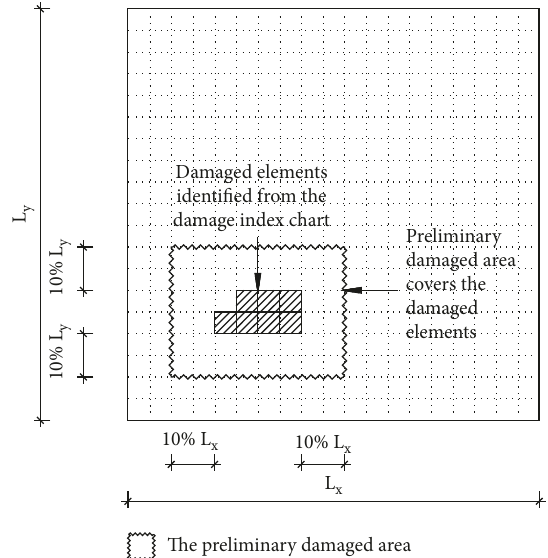
Figure 9: Preliminary damaged area detected from the global